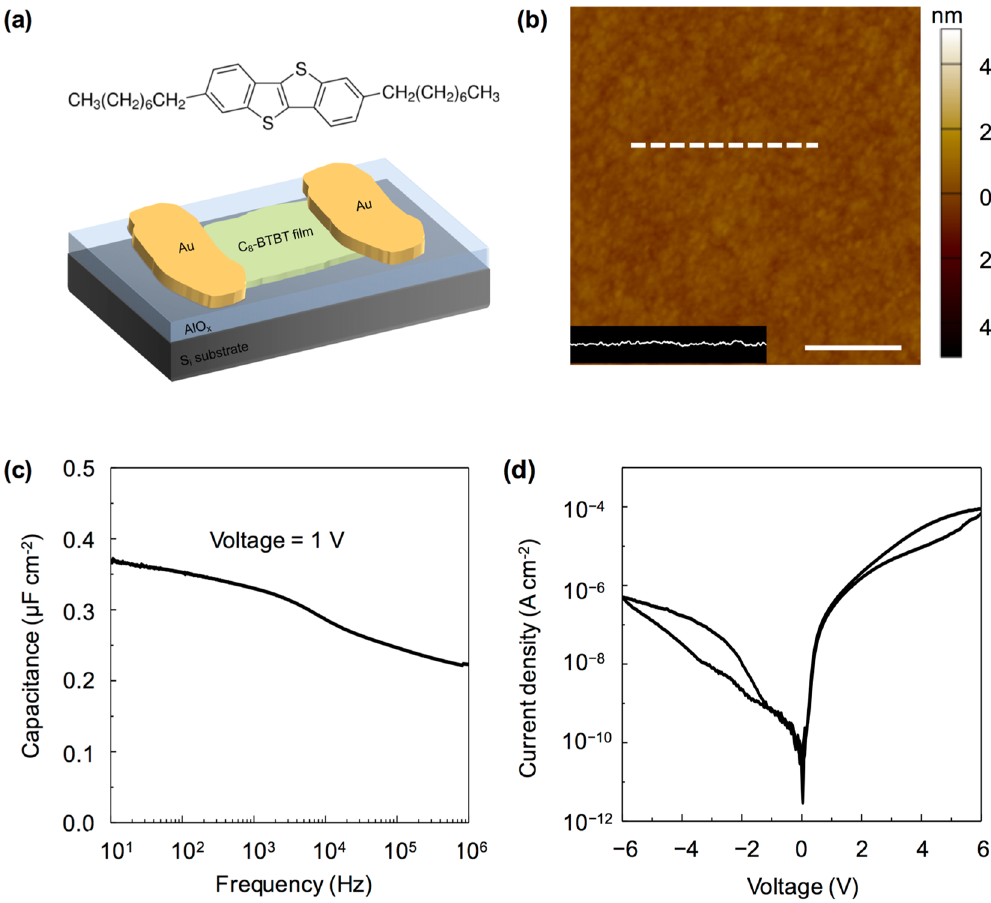
Figure 1. ( a ) Schematic of the BGTC transistor. ( b ) AFM morphology image of the AlO x dielectric. Scale bar, 500 nm. ( c ) Capacitance per unit versus frequency (at a voltage of 1 V). ( d ) Gate leakage current versus